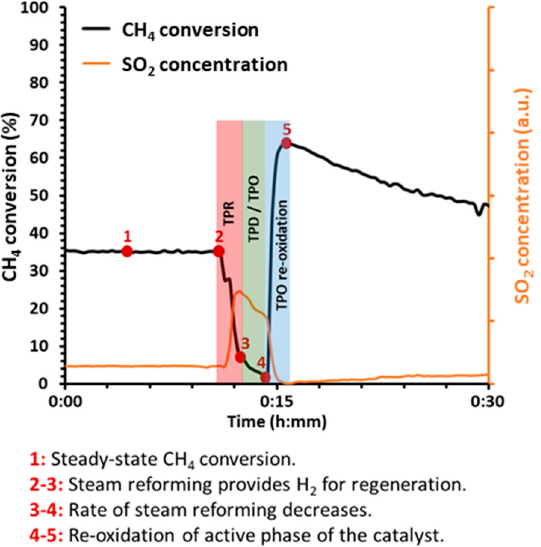
Figure 2. Detailed step ‐ wise description of the lean ‐ burn CH 4 combustion catalyst regeneration procedure. (TPR = Temperature Programmed Reduction, TPD = Temperature Programmed Desorption, and TPO = Temperature Programmed Oxidation).